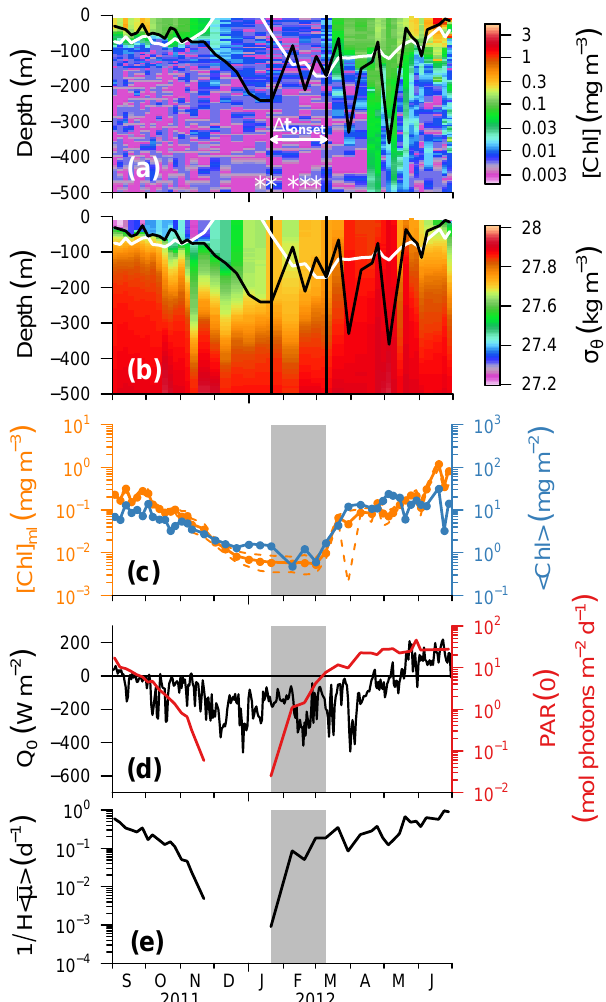
Figure 2. Bloom observed by float IMR2 during the autumn– spring 2011–2012. (a) Time evolution of the vertical distribution of [Chl a ]. The asterisks indicate the vertical profiles where the ML fluorescence values are not significantly different from the deep fluorescence values. (b) Time evolution of the vertical distribution of potential density σ θ . The black and white continuous lines are the mixed layer, H , and euphotic layer depths, H eu , respectively. (c) Time series of the vertical integral and the average concentra- tion of [Chl a ] in the ML (<Chl>, blue lines and [Chl] ML , orange line). The dashed lines are the standard deviations around the aver- age cycle of [Chl] ML . (d) Time series of the daily surface heat flux Q 0 (black line) and the daily surface PAR corrected for cloud cover, PAR(0) (red line). (e) Time series of the division rates averaged over the ML depth and over a day as described in Sect. 4.2.1. The two black vertical lines and the gray shading indicate (cid:49)t onset , the time period during which bloom onset is possible. The first vertical line marks the end of the polar night. The second black vertical line in- dicates t E , the sampling profile during which the ML fluorescence becomes significantly different from the deep fluorescence values (i.e., emergence of signal from